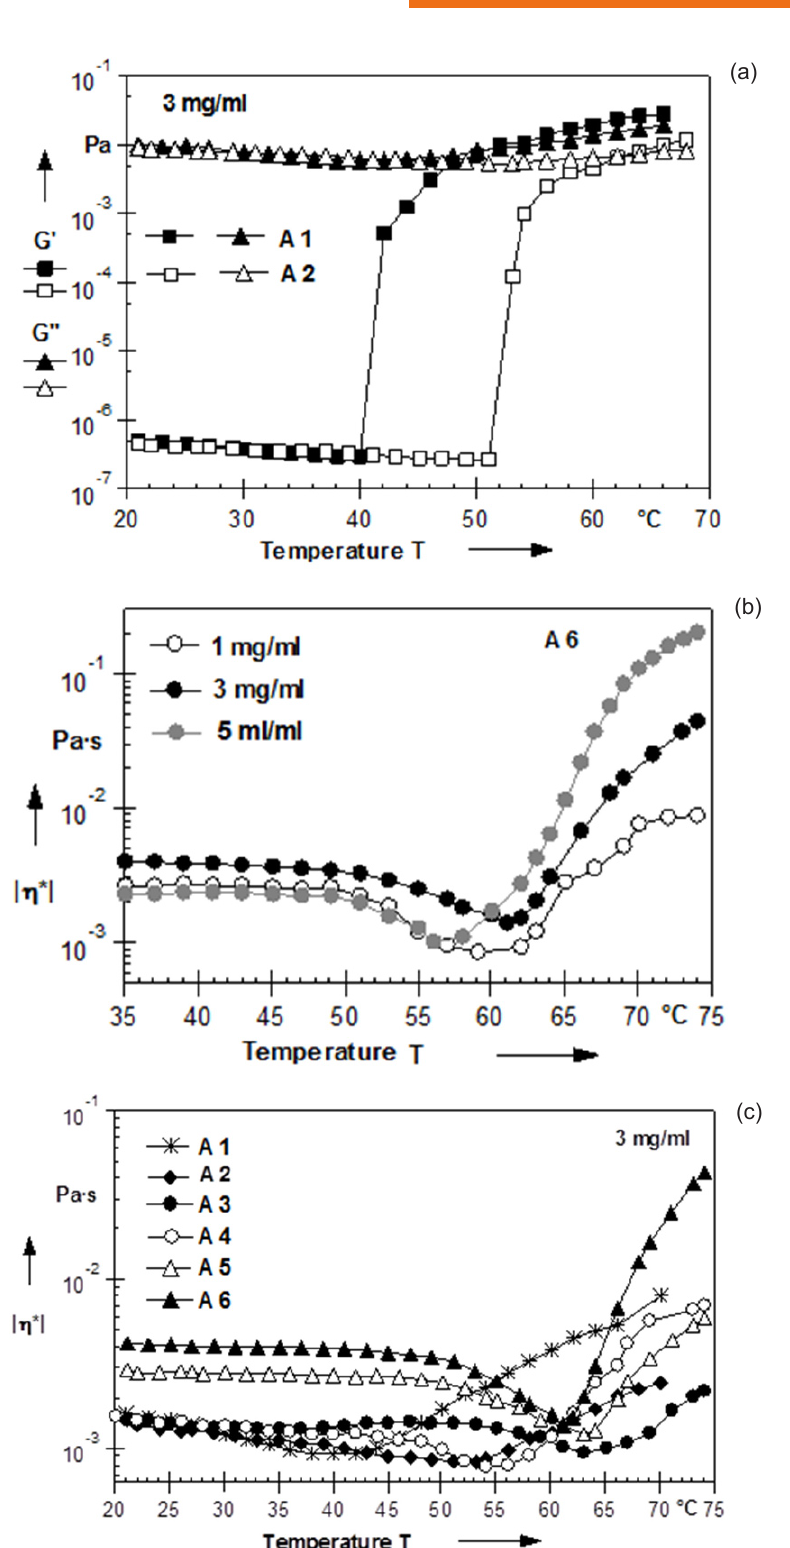
Figure 6. Temperature sweeps for a linear (A1) and cyclic (A2) PDMA graft polysiloxane (a); concentration influence on the complex viscosity for A6 (b); complex viscosity variation with temperature for all graft polysiloxanes